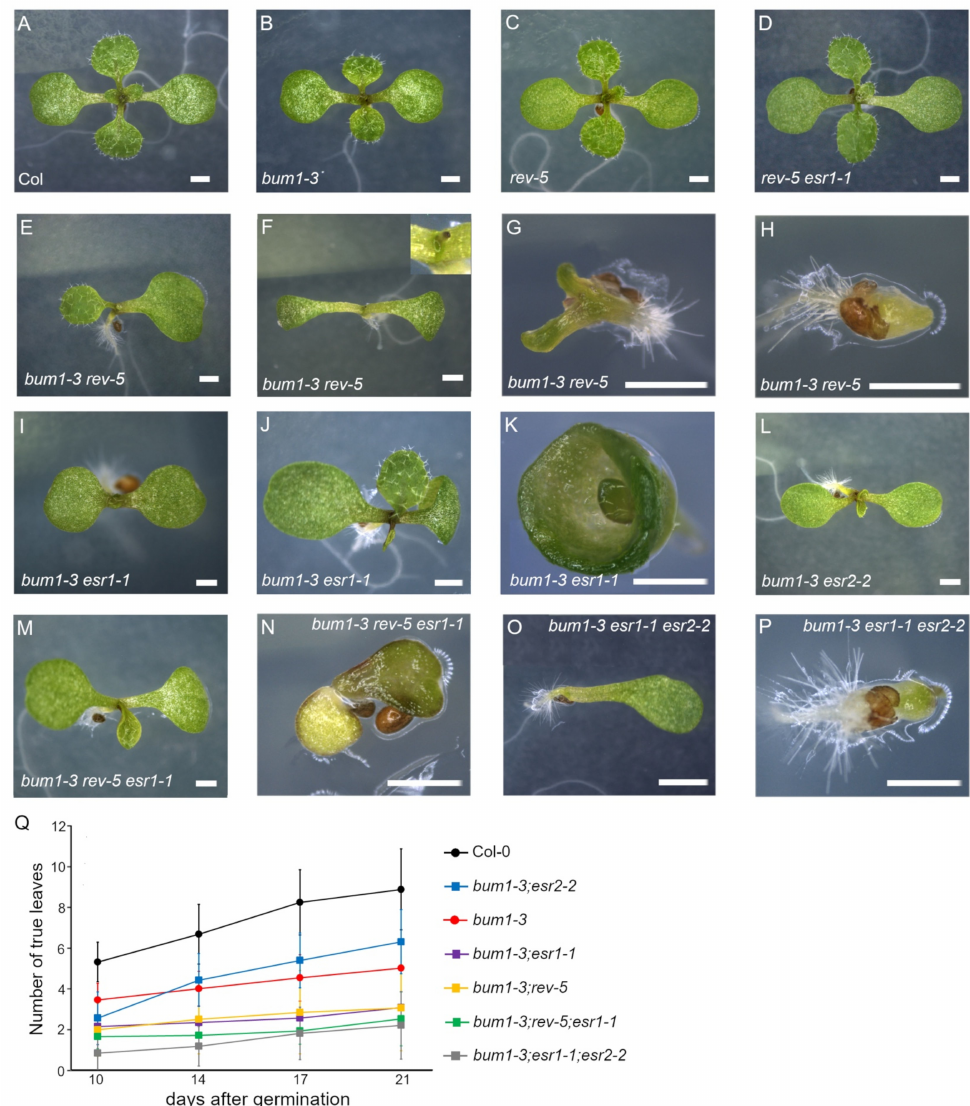
Figure 3. esr1 and rev additively enhance the bum phenotype. ( A ) Eight-day-old Col-0; ( B ) bum1-3 ; ( C ) rev-5 ; ( D ) rev-5 esr1-1 ; ( E – H ) bum1-3 rev-5 , note the single cotyledon in ( E ) and radial structure (inset) in ( F ); ( I – K ) bum1-3 esr1-1 ; ( L ) bum1-3 esr2-2 ; ( M,N ) bum1-3 rev-5 esr1-1 ; ( O,P ) bum1-3 esr1-1 esr2-2 ; ( Q ) number of developed rosette leaves in the respective mutant backgrounds at 10, 14, 17, and 21 d. a. g. Data shown are the mean ± SD of biological triplicates ( n > 50 per genotype). Scale bars = 1